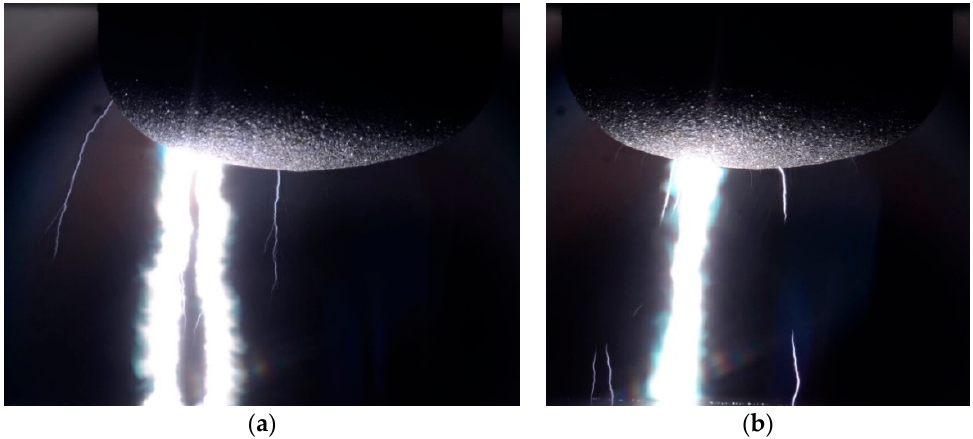
Figure 16. Images of partial discharges and breakdown in CO 2 at the small surface. ( a ) Positive polarity at a surface field of 322 kV/cm and ( b ) Negative polarity at 235 kV/cm surface field.